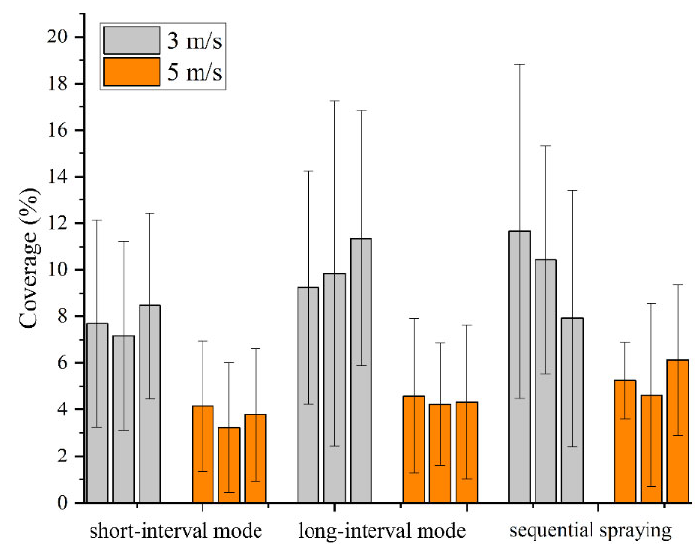
Figure 19. The results of droplet density in spray overlapping area.